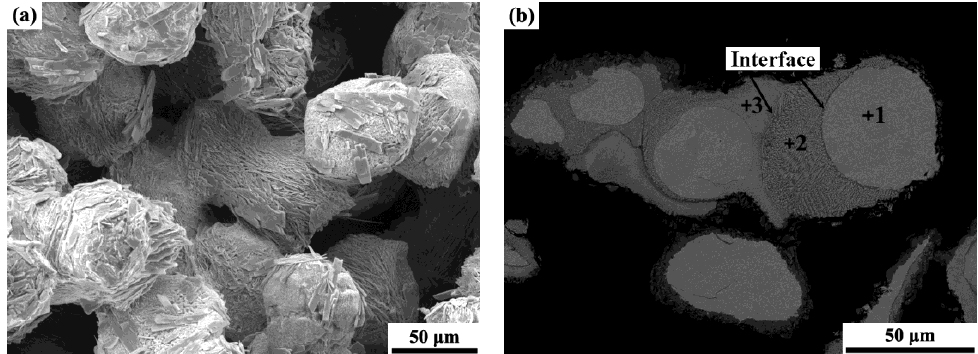
Figure 2. Cross-sectional microstructure of as-sprayed porous Mo surface morphology and inter-particle bonding neck. Table 1. Chemical compositions of the three points in Figure 2b.